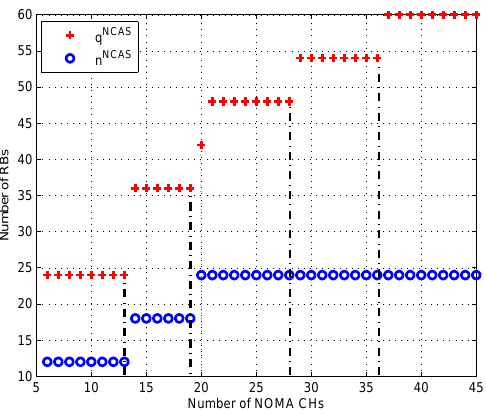
Figure 3. Comparison between q NCAS and n NCAS against the number of NOMA